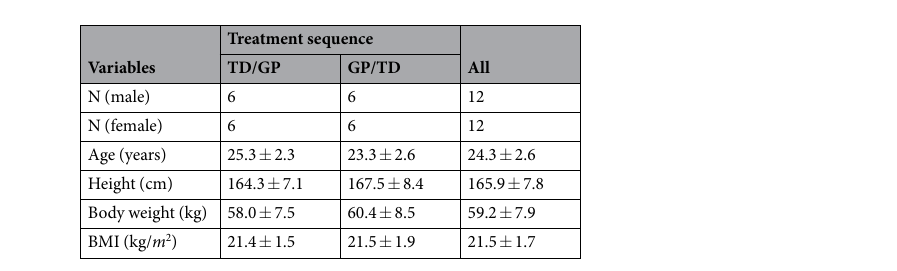
Table 1. Summary of demographic characteristics of subjects. Data are expressed as mean ±